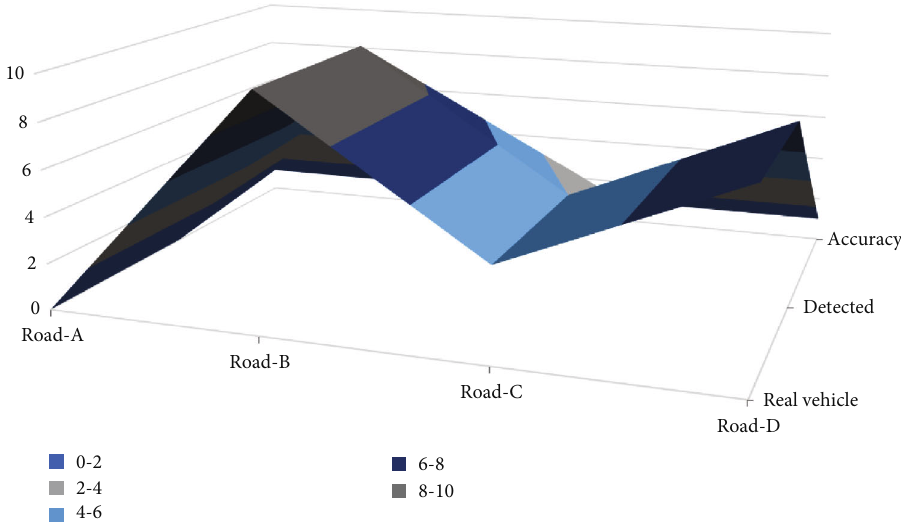
Figure 4: Vehicle detection accuracy on the road.